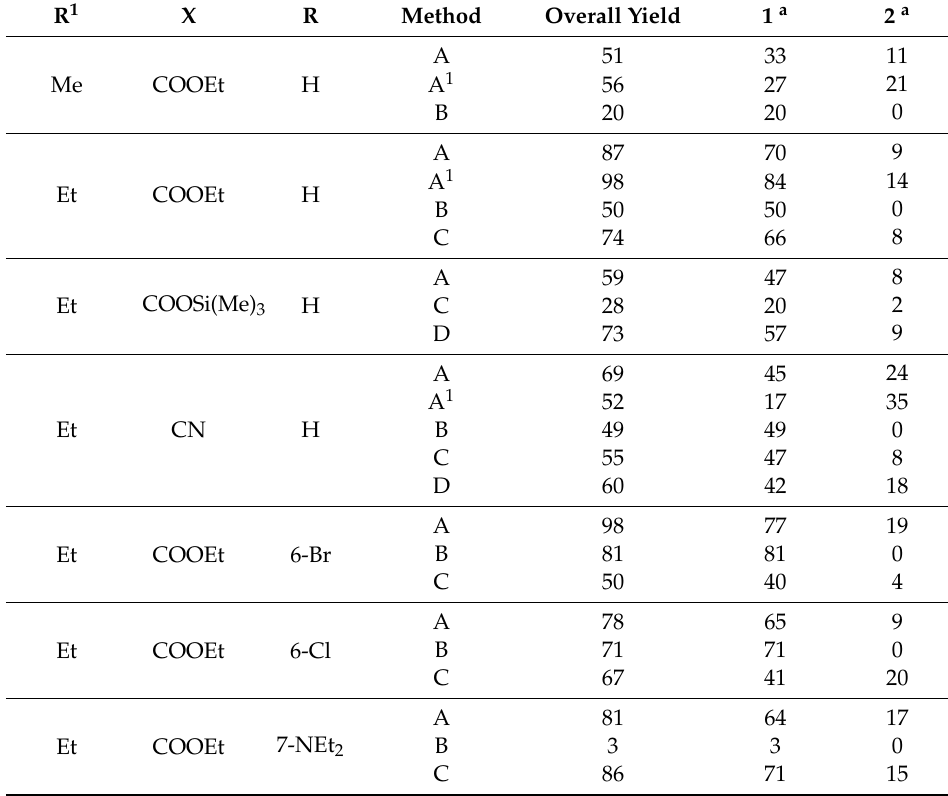
Table 1. Reaction conditions for the preparation of 1a – c,j and 2b – f using di ff erent catalysts. R 1 X R